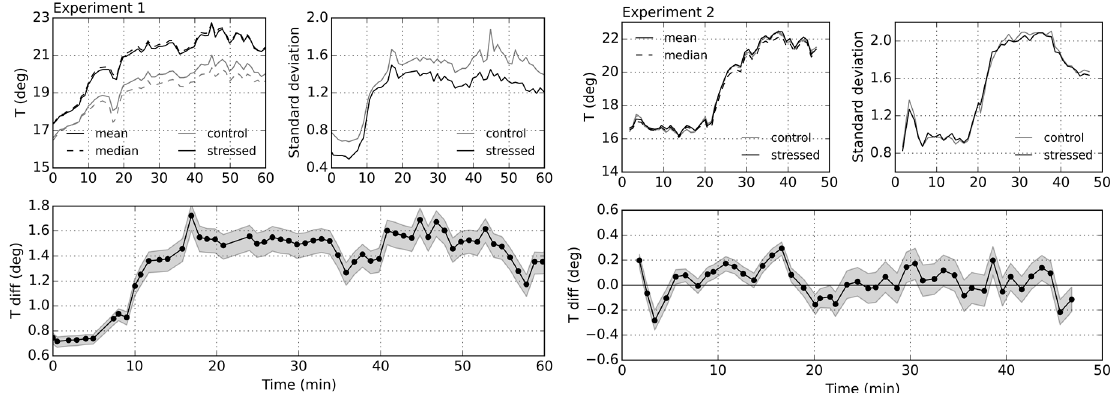
Figure 10. Mean and median temperature values over time for plants, alongside standard deviation ( top ); and difference in mean temperatures between stressed and control plants with 99% confidence intervals derived with Welch’s t-test ( bottom ). If confidence interval overlaps T diff = 0 °C, the temperature means are not significantly different at the given confidence level.